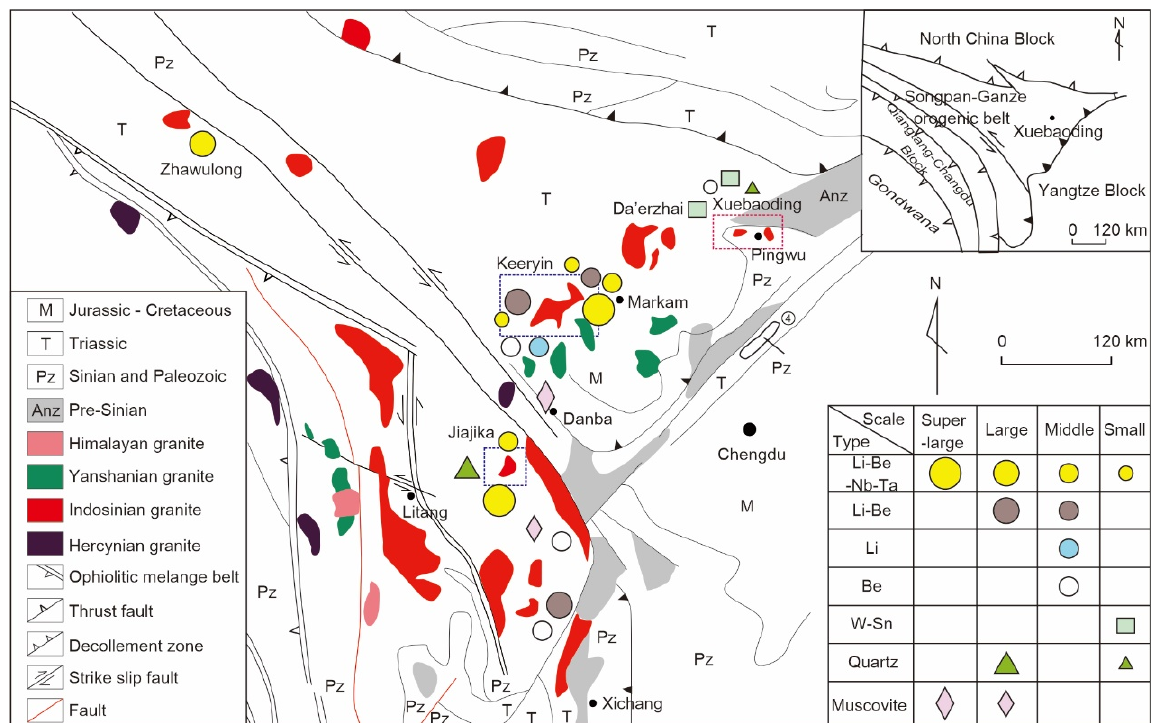
Figure 1. Sketch of regional tectonics and distribution of rare metal deposits in Western Sichuan, China (after [48]).